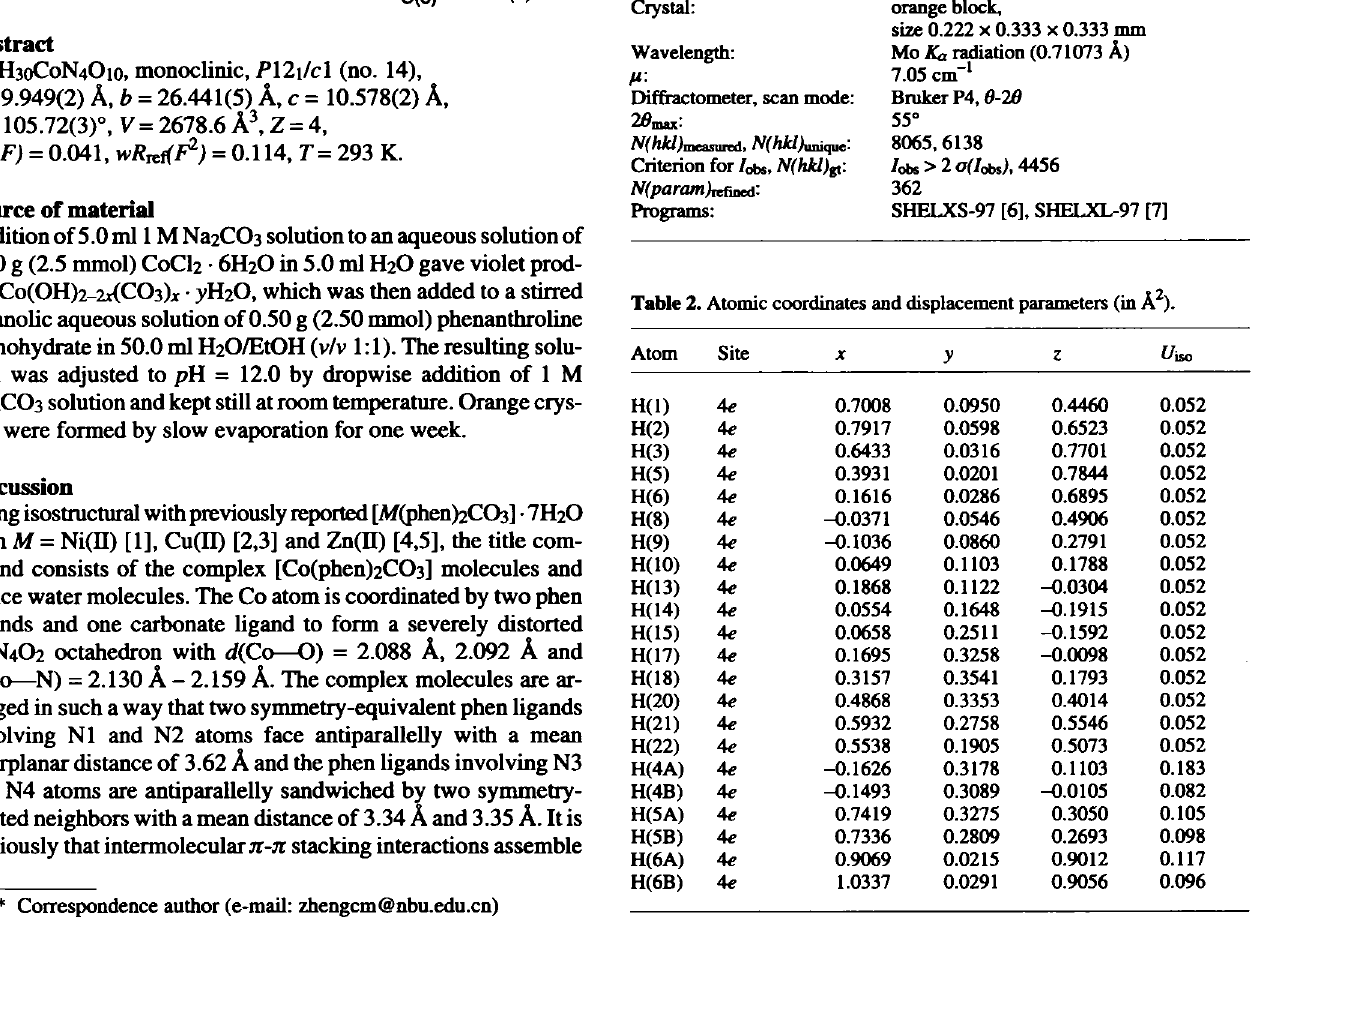
Table 1. Data collection and handling.